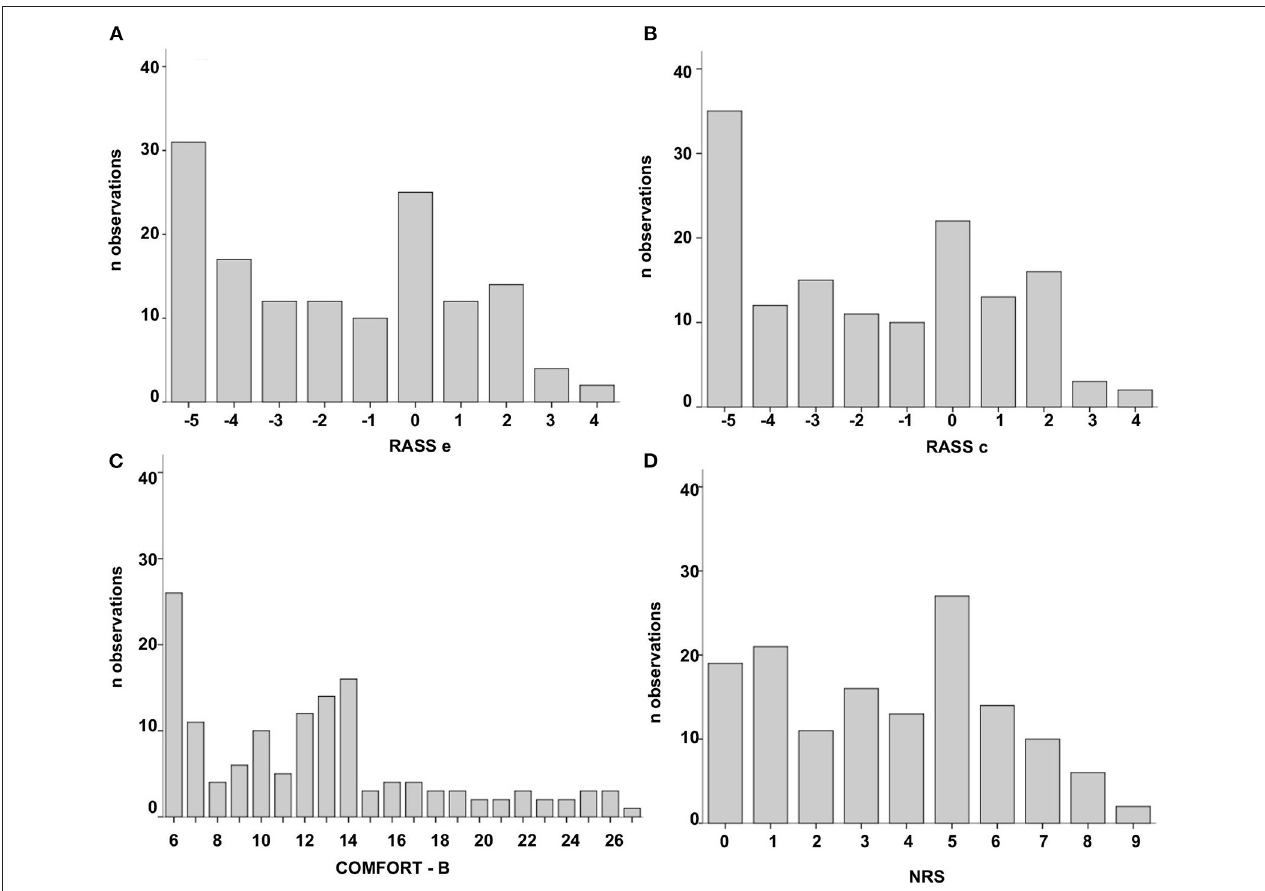
FIGURE 1 | Scores of the 546 observations in 139 patient episodes according to the scale used: (A) Richmond Agitation-Sedation Scale based on the epigraph (RASSe). (B) Richmond Agitation-Sedation Scale based on the description of the conduct (RASSc). (C) COMFORT Behavior Scale (COMFORT-B). (D) Numeric Rating Scale (NRS). TABLE 2 | Inter-rater reliability of the Richmond Agitation-Sedation Scale ( p < 0.001 in all cases). Observers group